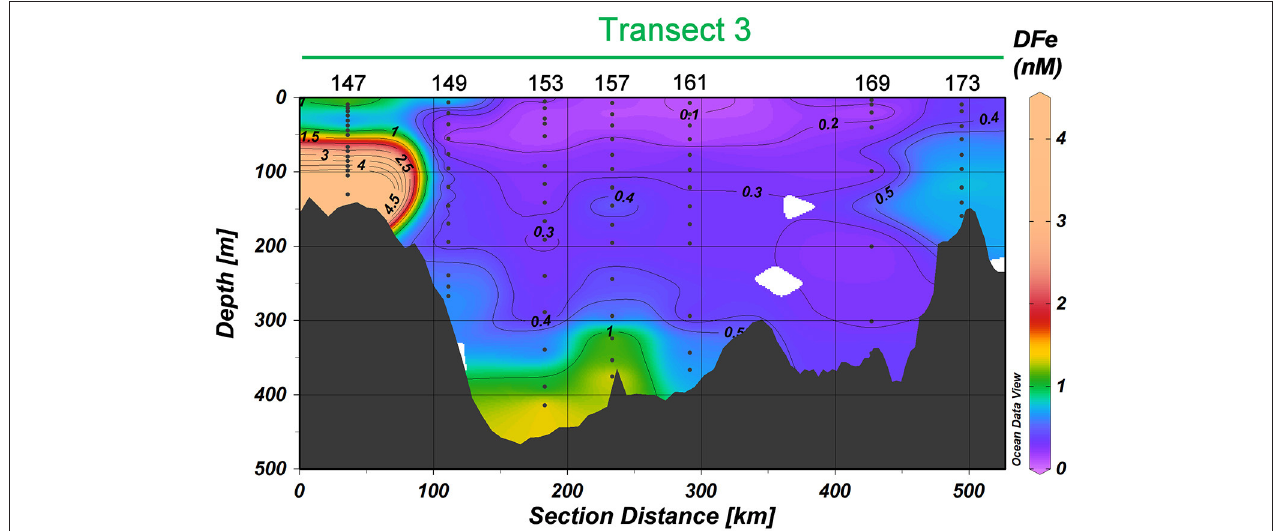
FIGURE 7 | DFe in nM in Transect 3. Station numbers are given (see Figure 1 ). Black contours indicate DFe and have an equidistance of 0.1nM for the range 0 ≤ DFe ≤ 0.5nM and of 0.5nM for the range 0.5 < DFe ≤